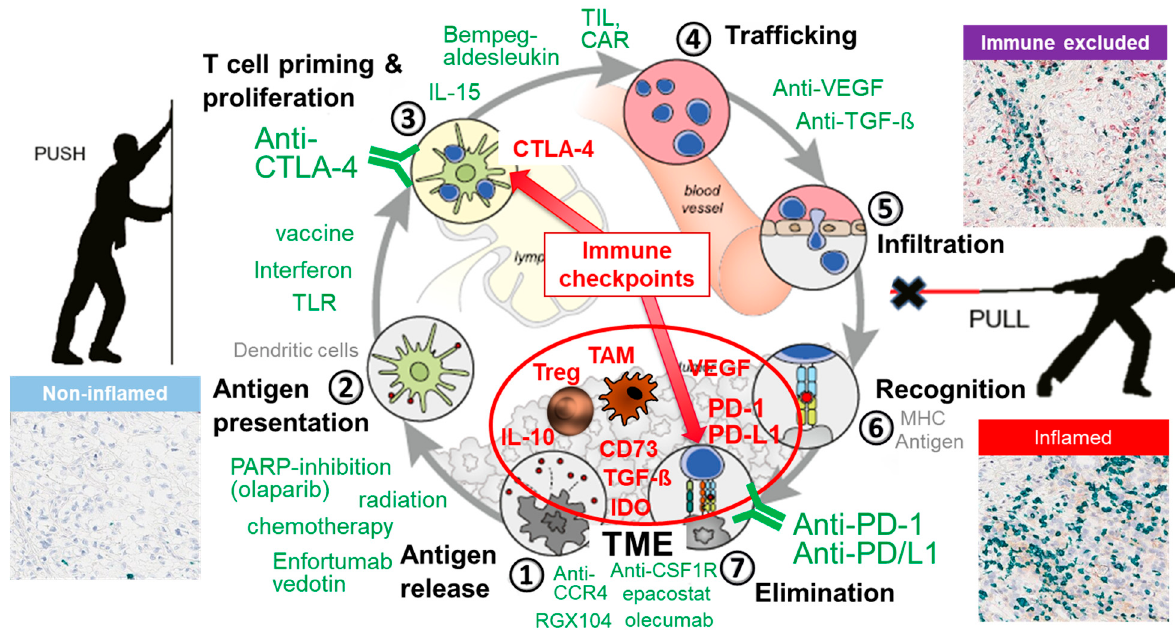
Figure 1. Cancer immunity cycle and therapeutic choices: 7 steps are required for a successful antitumor immune response [23]. CTLA-4 (cytotoxic T lymphocyte antigen-4) and PD-1 (programmed death-1) with its ligand PD-L1 are checkpoints—